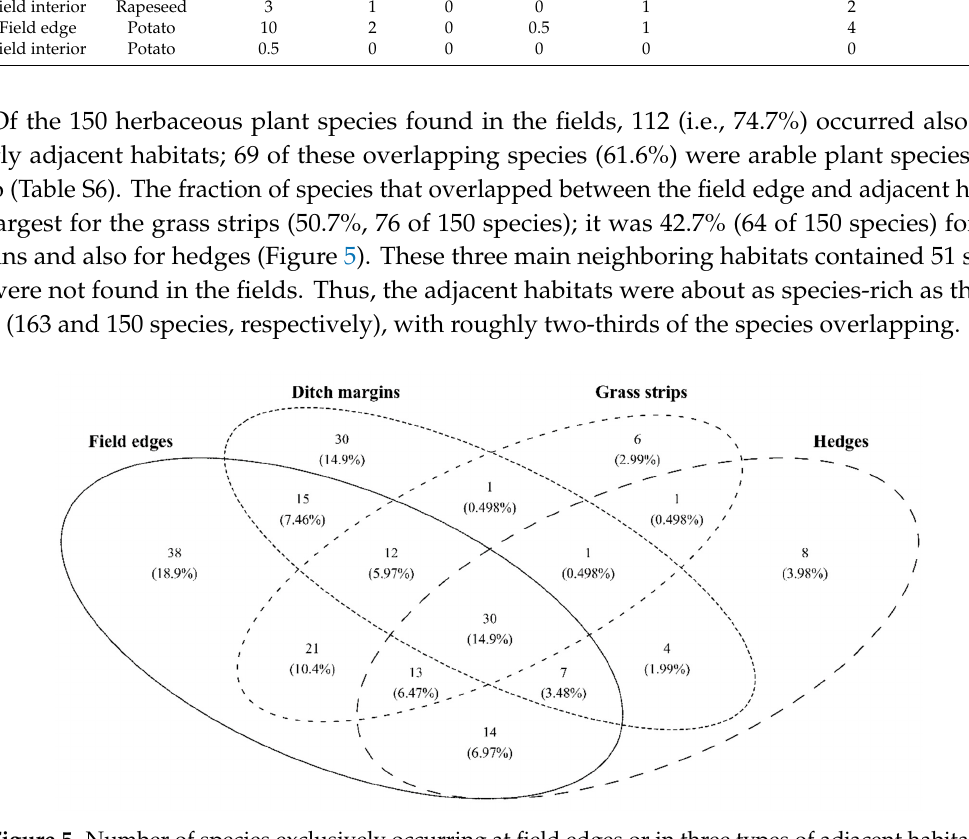
Figure 5. Number of species exclusively occurring at field edges or in three types of adjacent habitats, or that are shared with other habitats in the study region. Indicated are the species number and the proportion of the total species pool (in %) for herbaceous plant species richness (in total 201 species, woody plant seedlings and crops excluded); n : edge plots = 200, ditch margins = 21, grass strips = 20, hedges = 22.